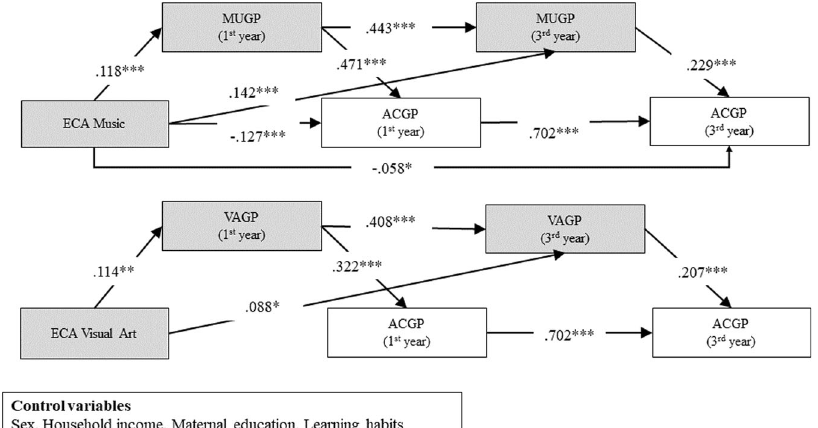
Fig. 2 Direct and indirect pathways from extracurricular activity in music and visual arts to academic performance, mediated by music and visual arts scores with SES controls. Note: ECA is extracurricular activity, GP is fi nal grade point in a subject summarized at the end of a school year, MUGP is music GP, VAGP is visual arts GP, and ACGP is general academic score which is calculated by fi ve major subjects GP. Structural equation modeling N = 488, χ 2 (df = 163) = 485.92 ( p < 0.001), CFI = 0.95, GFI = 0.99, AGFI = 0.98, RMSEA = 0.06; dotted paths denote non-signi fi cant effects, while solid-line paths denote signi fi cant effects. Values are presented as standardized β ( b *), after controlling for sex, household income, maternal education and learning habits.